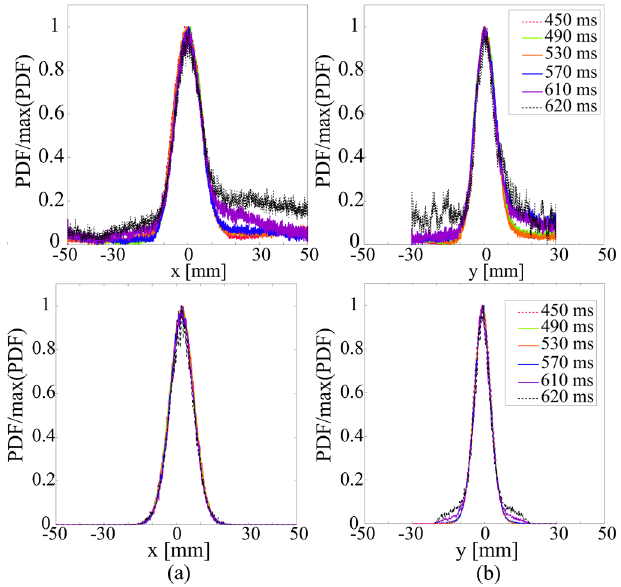
FIG. 6. Measured (top) and simulated (bottom) horizontal (a) and vertical (b) profiles in [450 – 620] ms for the long bunch case, normalized with respect to the max value.